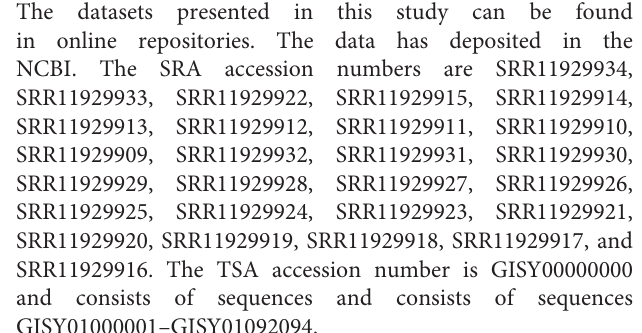
FIGURE S1 | The flow chart of the prediction of candidate secreted effector